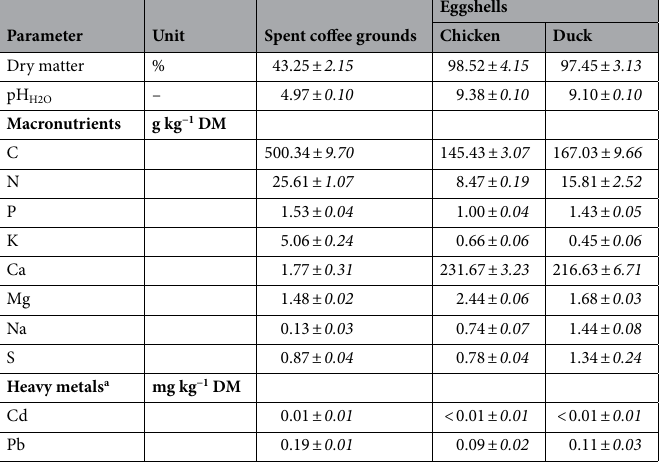
Table 1. Basic physicochemical properties of spent coffee grounds and bird eggshells. a Permissible content